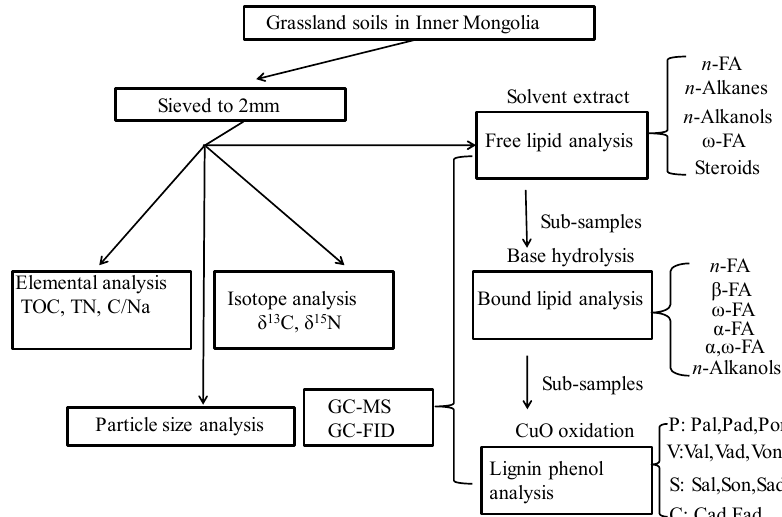
Figure 2. Flow chart of bulk parameters and molecular biomarker analyses for grassland soils, Inner Mongolia. FA = fatty